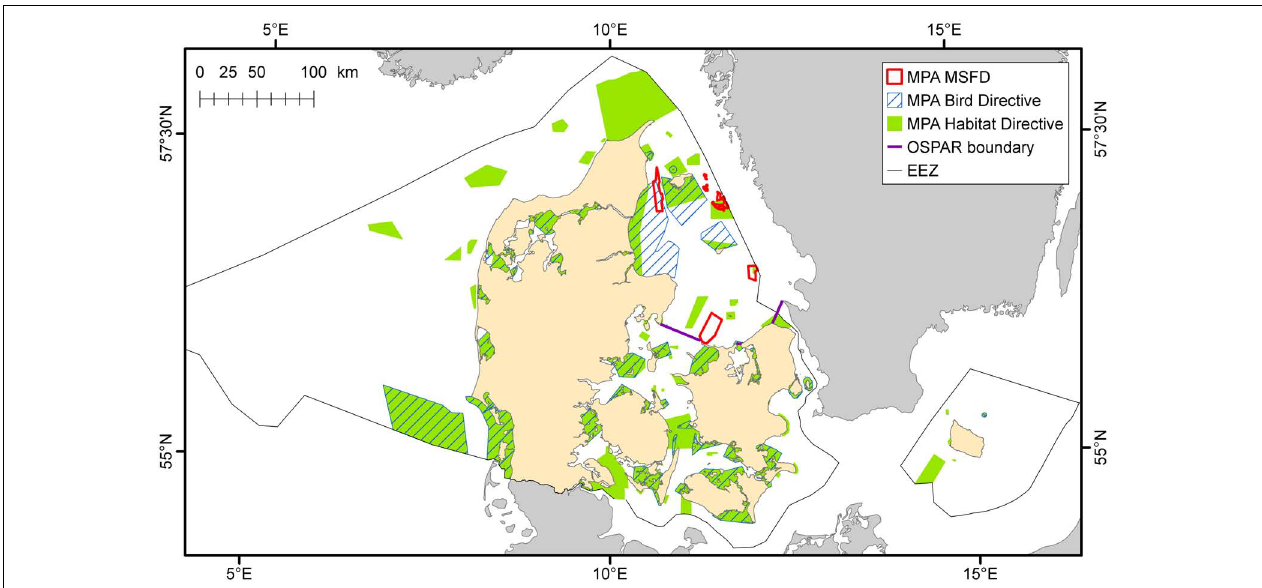
FIGURE 2 | Areas appointed according to the BD (hatched), the HD (green) together make up the Natura 2000 sites. MPAs appointed according to the MSFD (see the section “Denmark”) are marked with